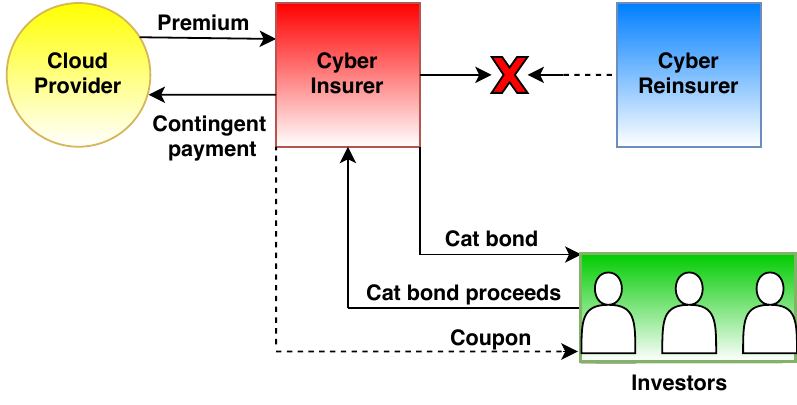
Figure 3. Process of cash